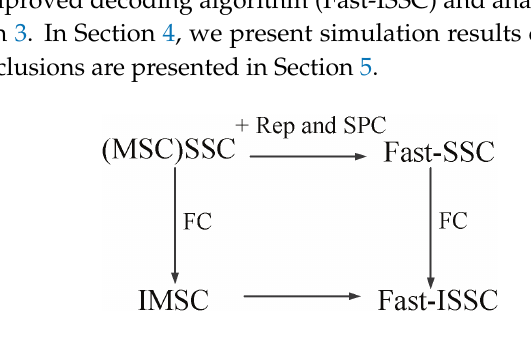
Figure 1. Relationships between the various SC decoding latency reduction